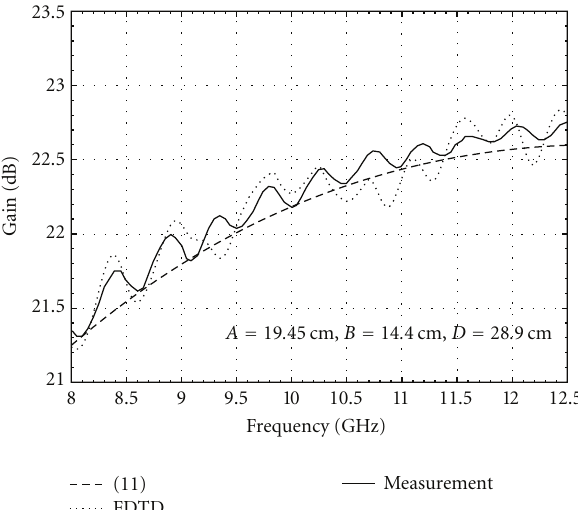
Figure 5: AF of pyramidal horn due to the incidence of cross- polarized electric field.